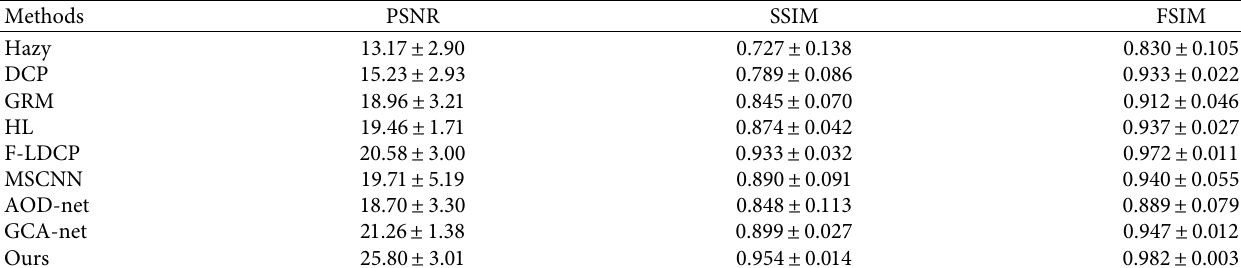
Figure 7: The box-plot of PSNR, SSIM, and FSIM values of various methods on all hazy images shown in Figure 5. From top to bottom: the synthetic hazy experiment with A 0 . 9/ t � 0 . 2, respectively. Note that IQR represents interquartile range. Table 2: PSNR, SSIM, and FSIM comparisons (mean ± std) of various image enhancement methods on all test images shown in Figure 5. The best results are highlighted in bold.